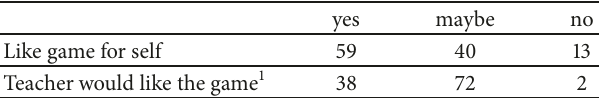
Table 2: Assessment of whether teacher or self would like the game version.